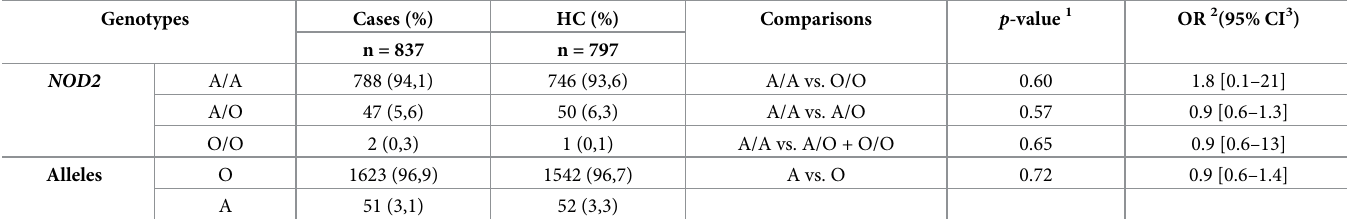
376 (269 males and 107 females) HC. The mean age (mean ± standard error of the mean) of the Table 4. Pooled combination of the genotypes and alleles of the three variants R702W, G908R, and L1007fsinsC among patients with Lg -CL (cases) and healthy con- trols (HC).